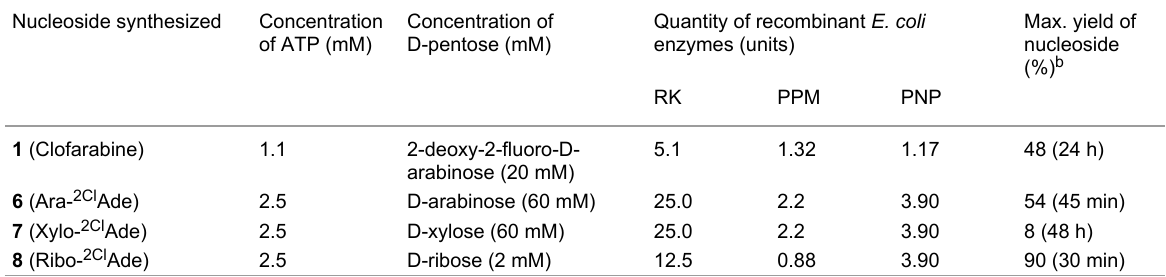
Table 4: Variably optimized reaction conditions for the synthesis of 2-chloroadenine nucleosides. a